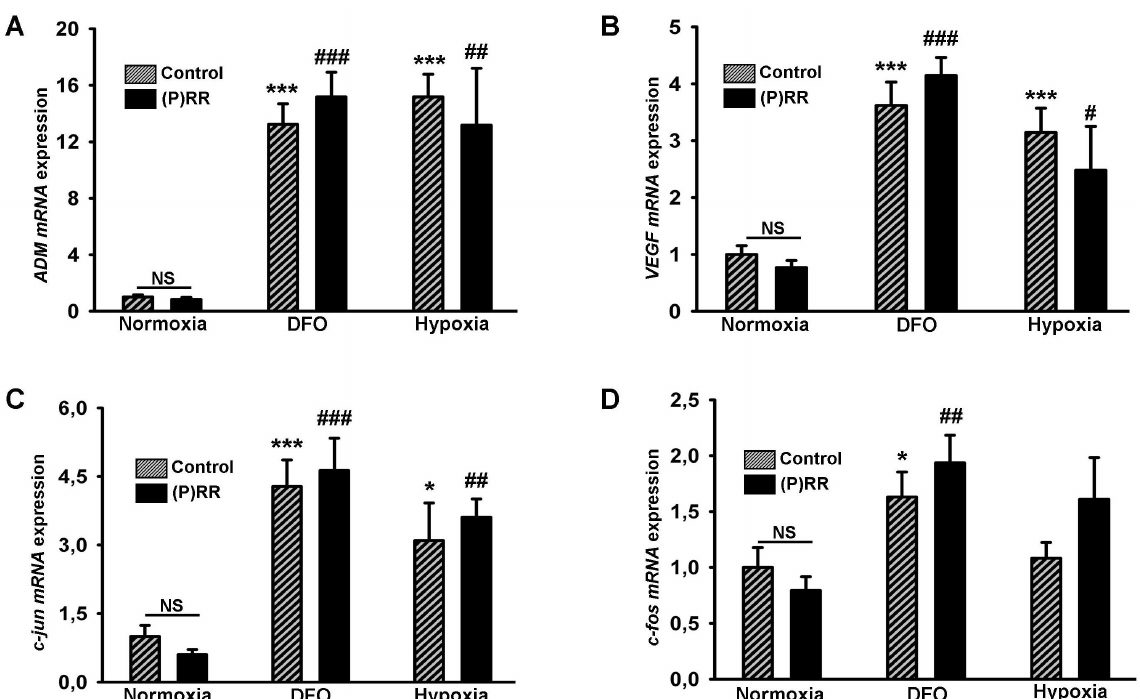
Figure 5. Effect of (P)RR overexpression on stress related gene expression due to hypoxia. Gene expression levels in HeLa cells under normoxia, DFO (deferoxamine) treatment and hypoxia; HeLa cells without (fine bars) and with (black bars) (P)RR overexpression. A) ADM B) VEGF C) c- jun D) c-fos (all normalized to GAPDH ). * P , 0.05 , *** P , 0.001 , normoxia vs. DFO or normoxia vs. hypoxia, under control condition. # P , 0.05, ## P , 0.01 and ### P , 0.001 , normoxia vs. DFO or normoxia vs. hypoxia, under (P)RR